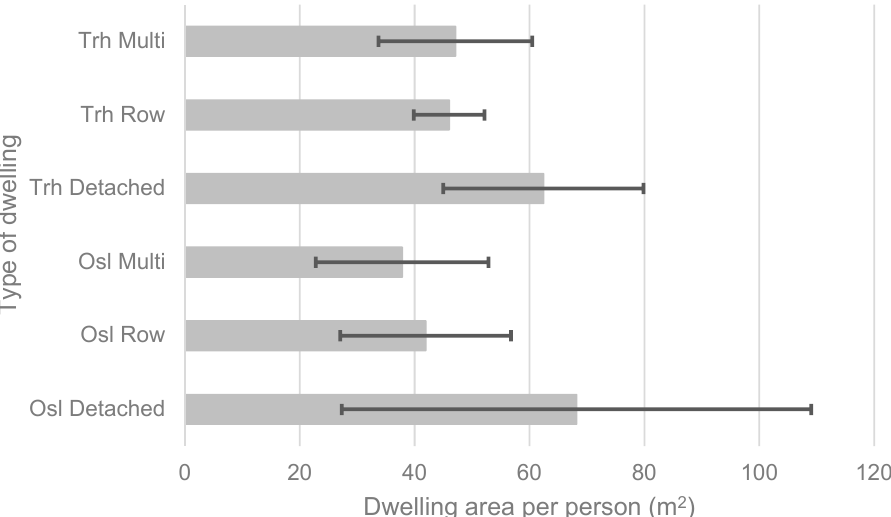
Figure 6. Dwelling area per person (mean and standard deviation) for different dwelling types in Oslo and Trondheim.